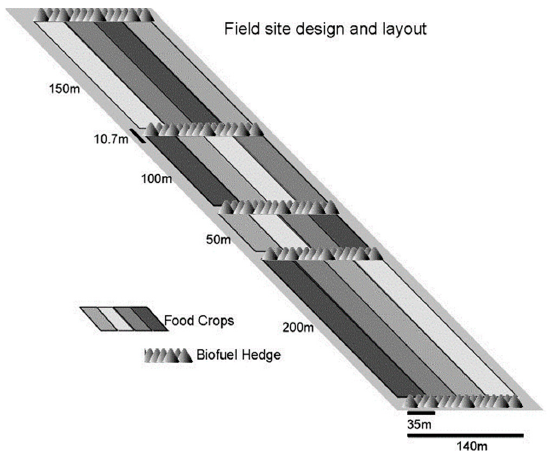
Figure 1. Field layout of the combined food and energy (CFE) system at the experimental farm in Taastrup, Denmark.